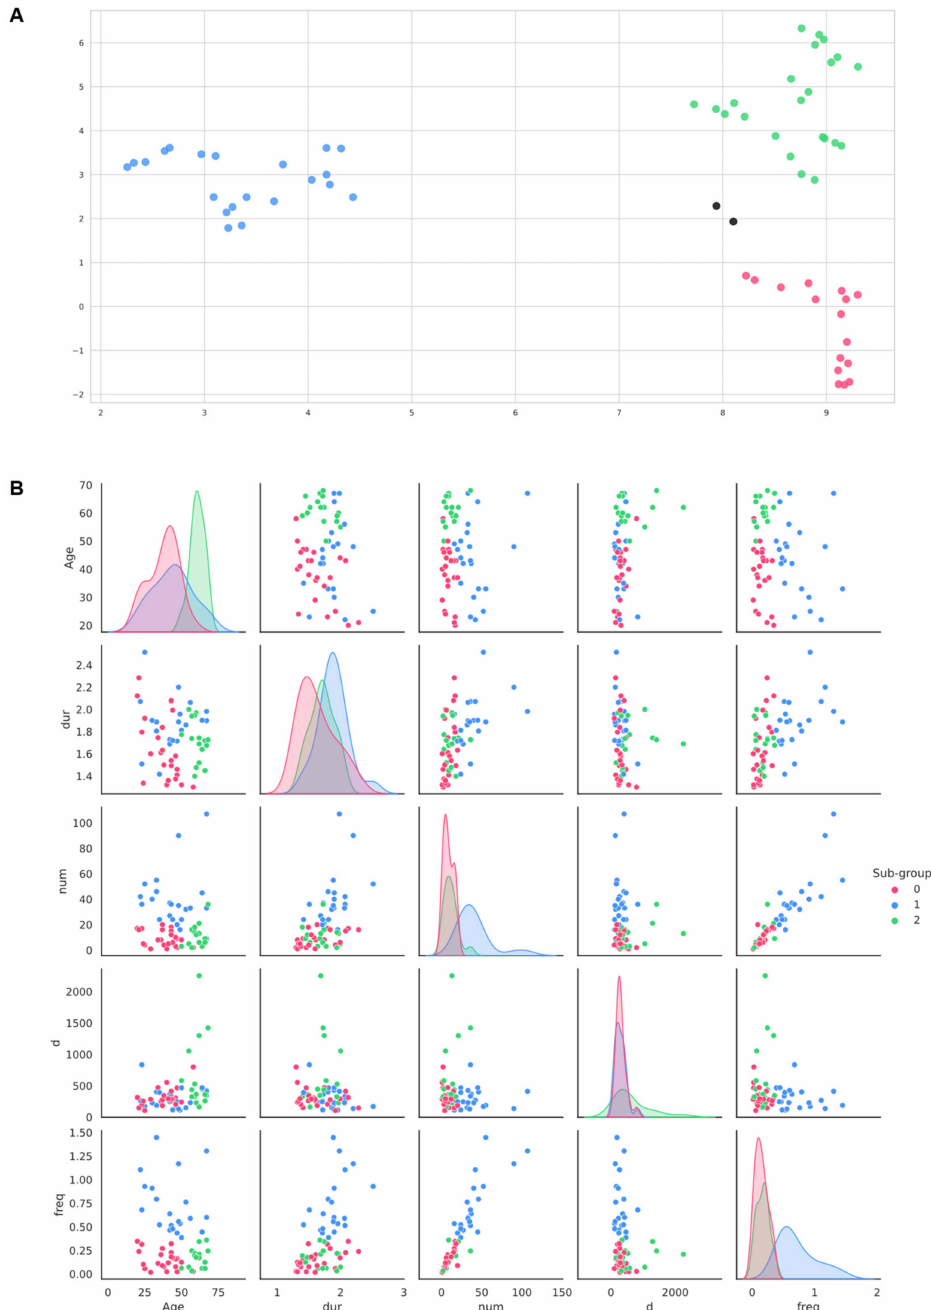
Figure 2. ( A ) HDBSCAN clusters on 2-components UMAP output, the 2 black marks represent the single data points classified as noise; ( B ) Eye-contact metrics and age pairplot; freq: frequency of eye-contact episodes; num: total number of eye-contact episodes; dur: average duration of eye-contact episodes; d: average distance of children’s gaze vectors from therapists’ headboxes during interaction; age: children’s age at first